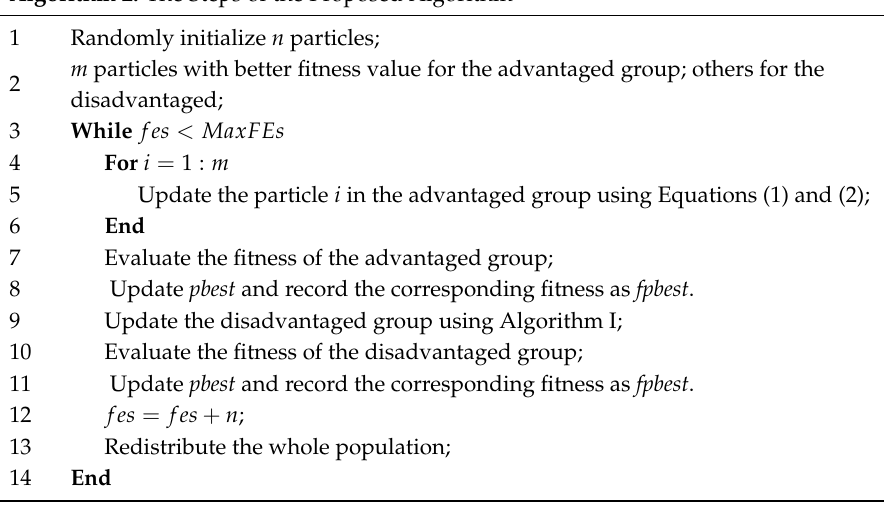
Algorithm 2. The Steps of the Proposed